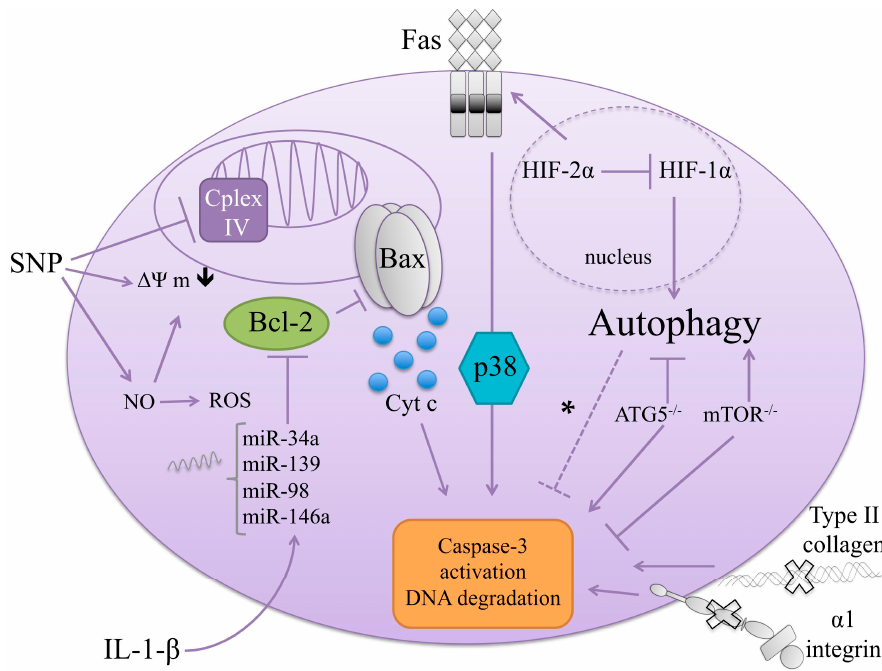
Figure 1. Molecular mechanisms of chondrocyte cell death. Chondrocyte death can be mediated by mitochondria dysfunction, Fas/FasL engagement, as well as by Nitric Oxide (NO) and Reactive Oxygen Species (ROS) production. p38 is often emphasized as a mediator of chondrocyte cell death, using various stimuli. Silencing of type II collagen or α 1 integrin can cause chondrocyte cell death. Numerous miRNAs are IL-1 β -responsive and play a role in osteoarthritis (OA) development and chondrocyte cell death. * The current view is that the trigger of autophagy in chondroctyes aims to avoid cell death, especially in the early stages of OA. However, the dotted arrow (depicted on the schema) emphasizes that excess autophagy can also lead to cell death.